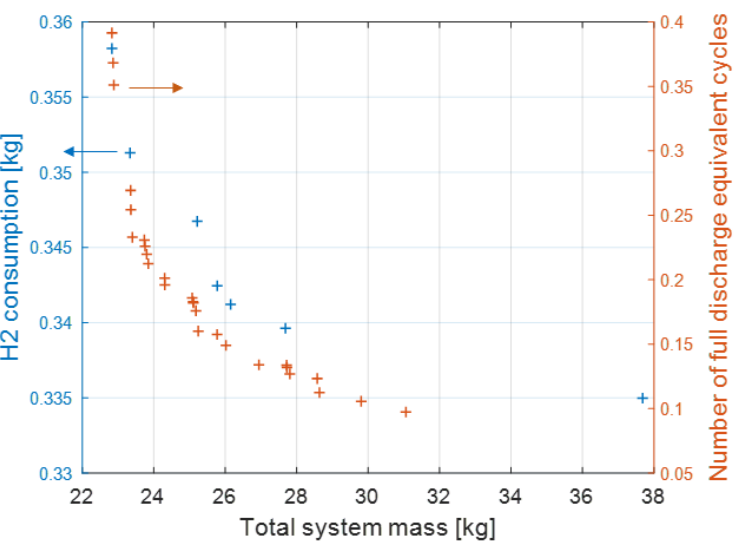
Figure 8. Pareto charts of H 2 consumption and number of battery full discharge equivalent cycles as a function of total system mass.